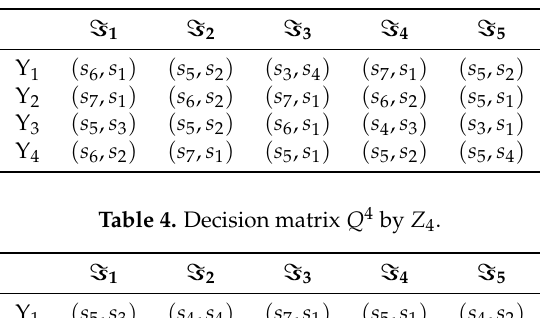
Table 3. Decision matrix Q 3 by Z 3 .